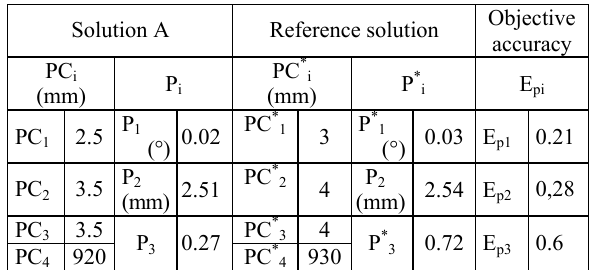
Table 3. The design and performance parameters of solution A and the reference solution